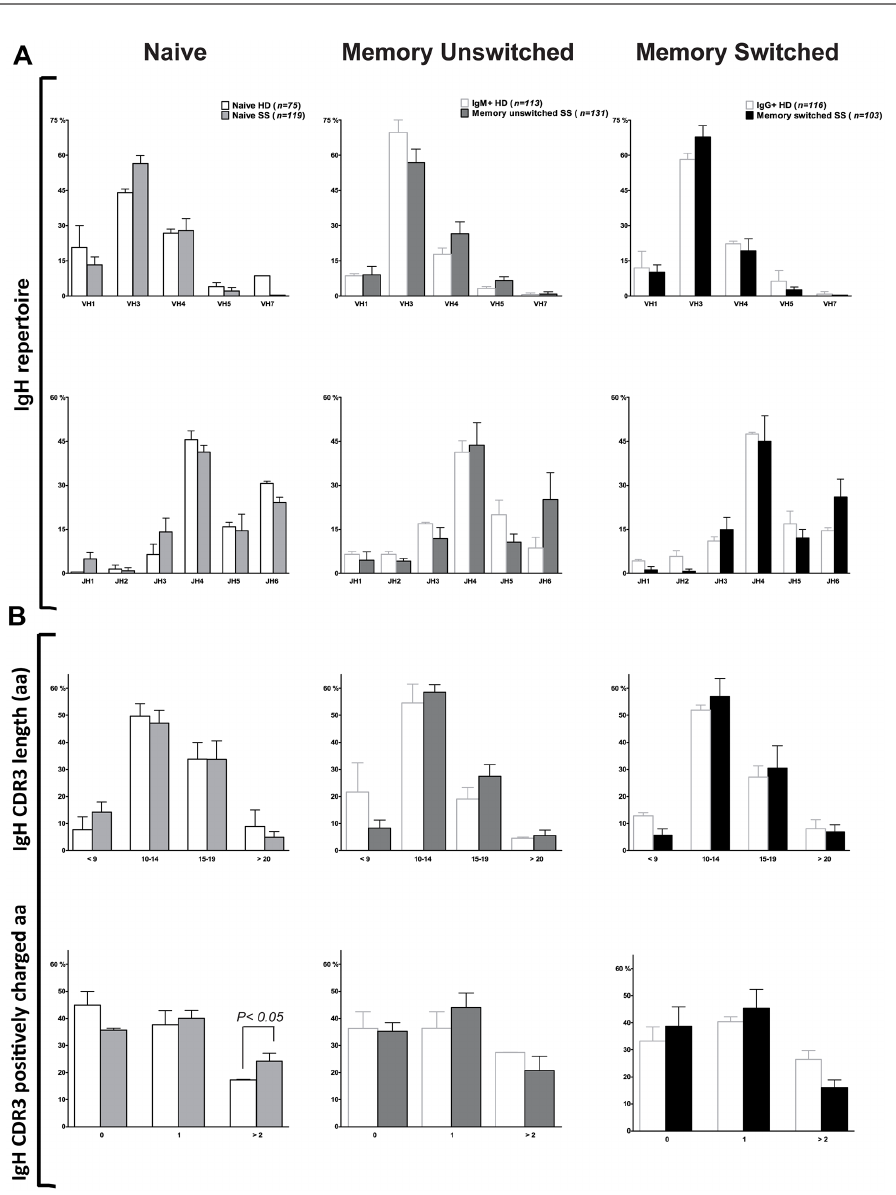
Fig. 2. Ig gene analysis of naı¨ve and memory B cells from SS patients and HD. Single naı¨ve and memory unswitched and switched B cell antibodies from SS patients and HD [19–21] were analyzed for ( A ) Ig V H family and J H gene usage, and ( B ) IgH CDR3 aa length and number of positive charges. The absolute number of sequences analyzed is reported over the graph. Error bars in bar graphs indicate standard error of mean (SEM) for individual patient or